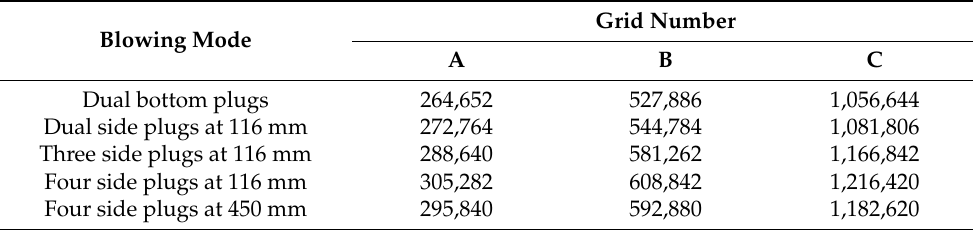
Table 3. Three grid numbers for each blowing mode.